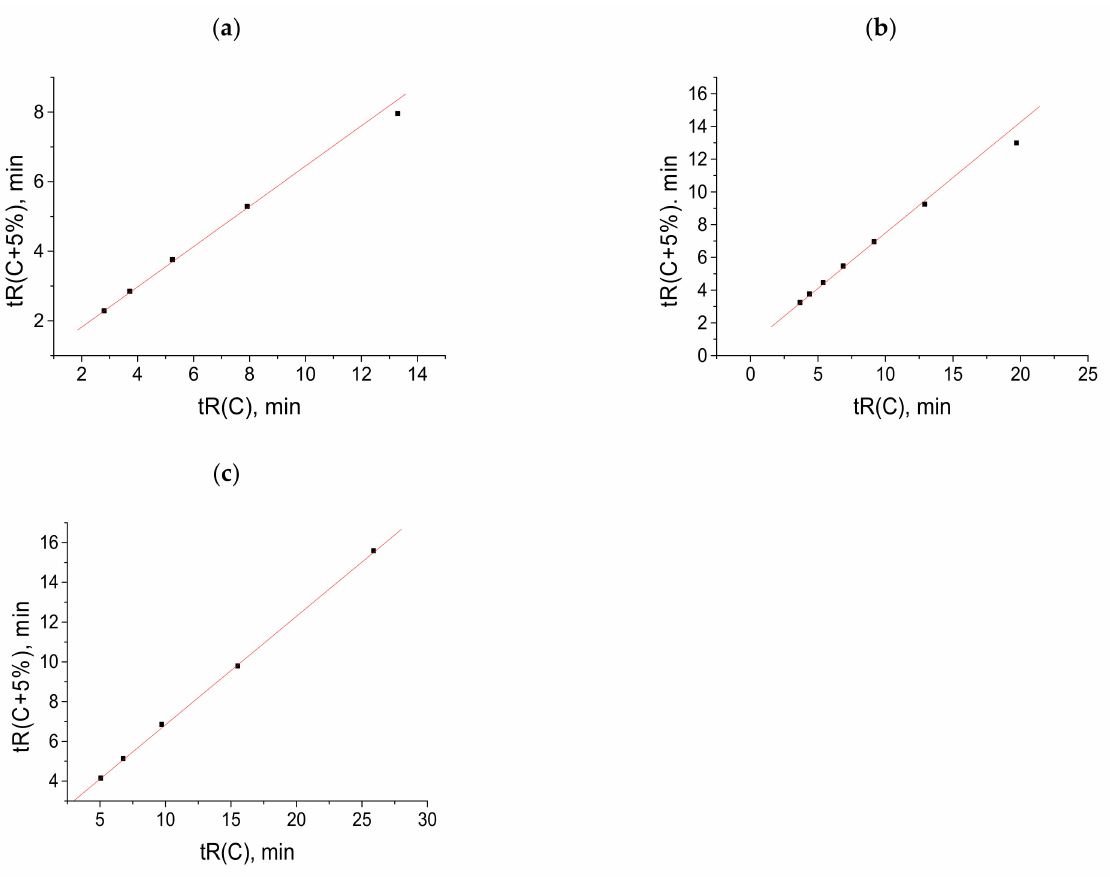
Figure 4. Recurrent approximation of the net retention times of N-hexyl- p -toluenesulfonamide, measured with ( a ) a 120 EC C18 column (eluent acetonitrile–water), ( b ) a 120 EC-CN column (the same eluent), and ( c ) a Phenomenex C18 column (eluent